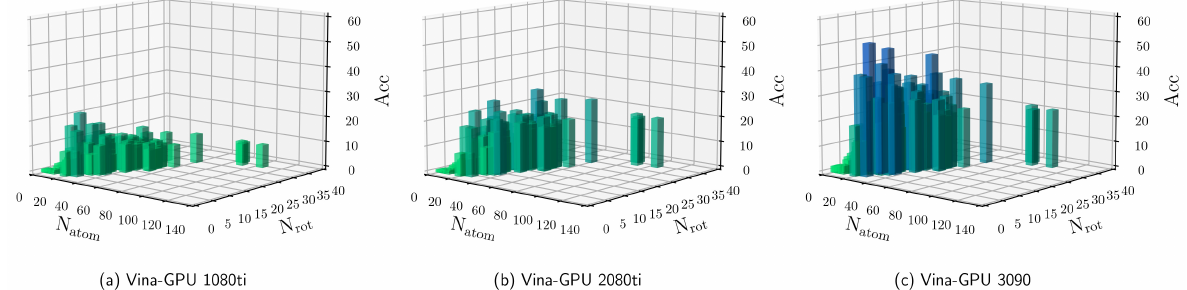
Figure 7. Details for the acceleration of docking time ( Acc ) of our Vina-GPU against AutoDock Vina on all 140 complexes. The complexity is depicted with their number of atoms ( N atom ) and rotatable bonds ( N rot ). The vertical axis ranges from 0 to 60, and each bar represents a complex coupling with its corresponding acceleration ( Acc ). Vina-GPU 1080ti, Vina-GPU 2080ti and Vina-GPU 3090 mean that Vina-GPU was executed on Nvidia Geforce GTX 1080ti, Nvidia Geforce RTX 2080Ti and Nvidia Geforce RTX 3090, respectively. The color depth of each bar indicates the value of accelerations (the darker the higher).